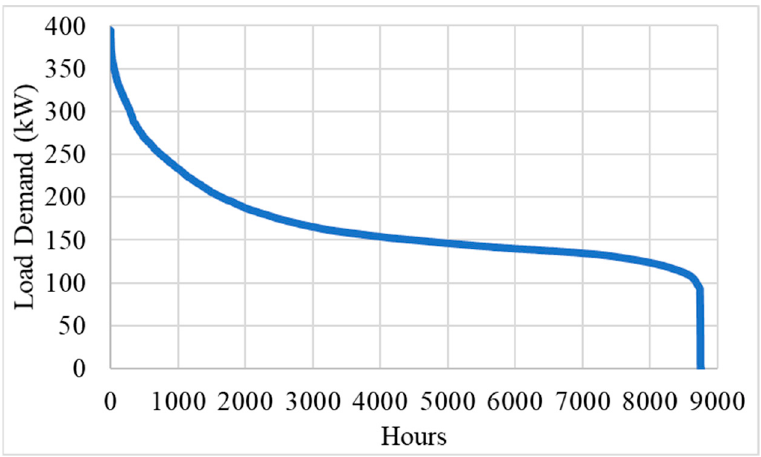
Figure 3. Duration curve of load demand for the HMU campus.